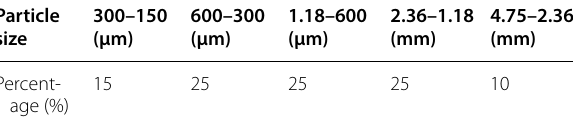
Table 1 Size distribution of artificial sand (fine